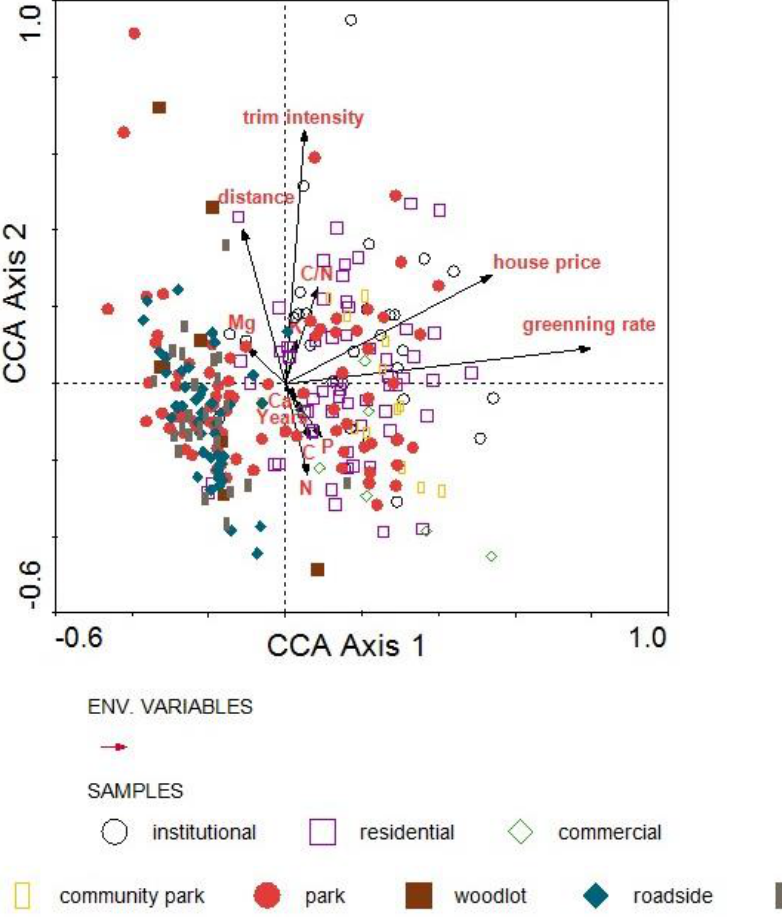
Figure 7. Canonical correspondence analysis (CCA) of plots and the environmental variables.